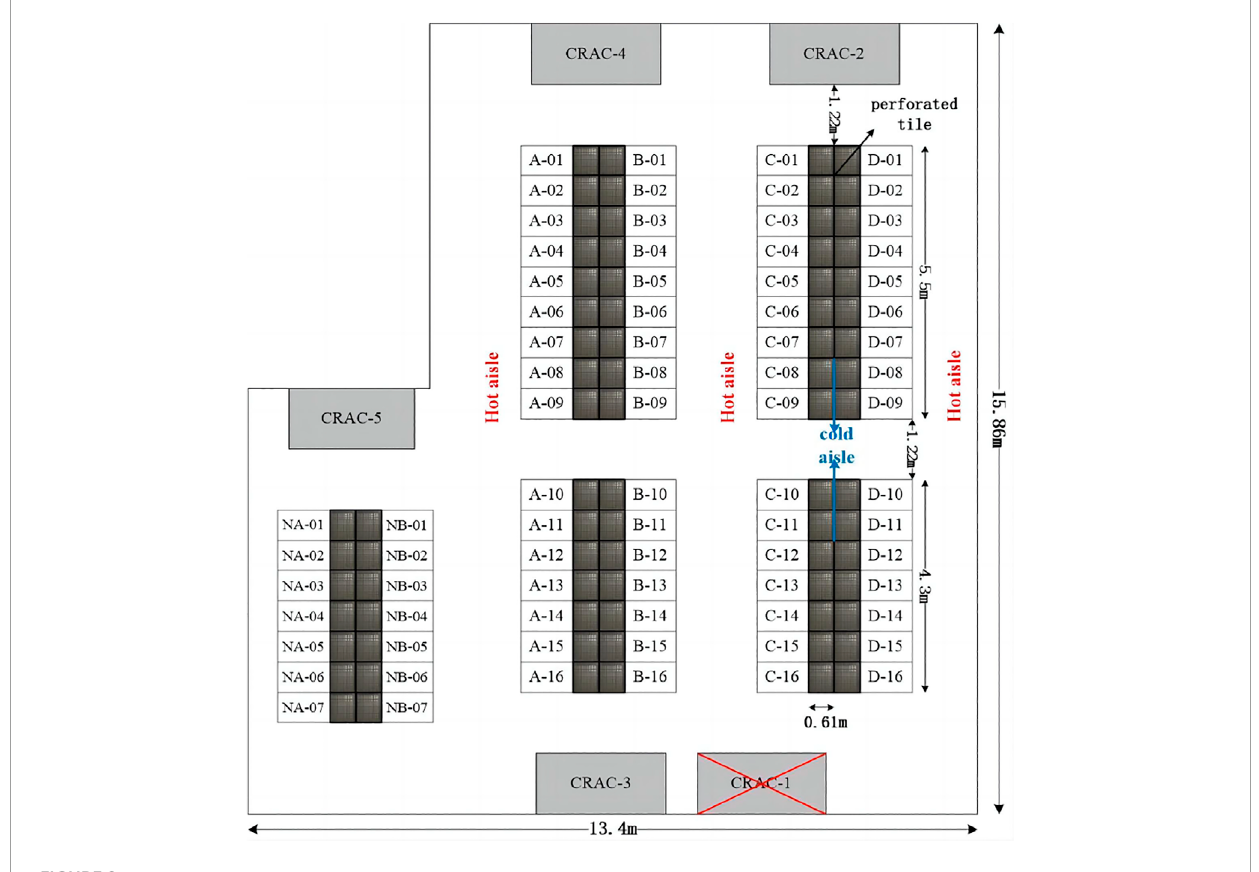
FIGURE 2 Layout of the data center of Inner Mongolia Meteorology Information Center.